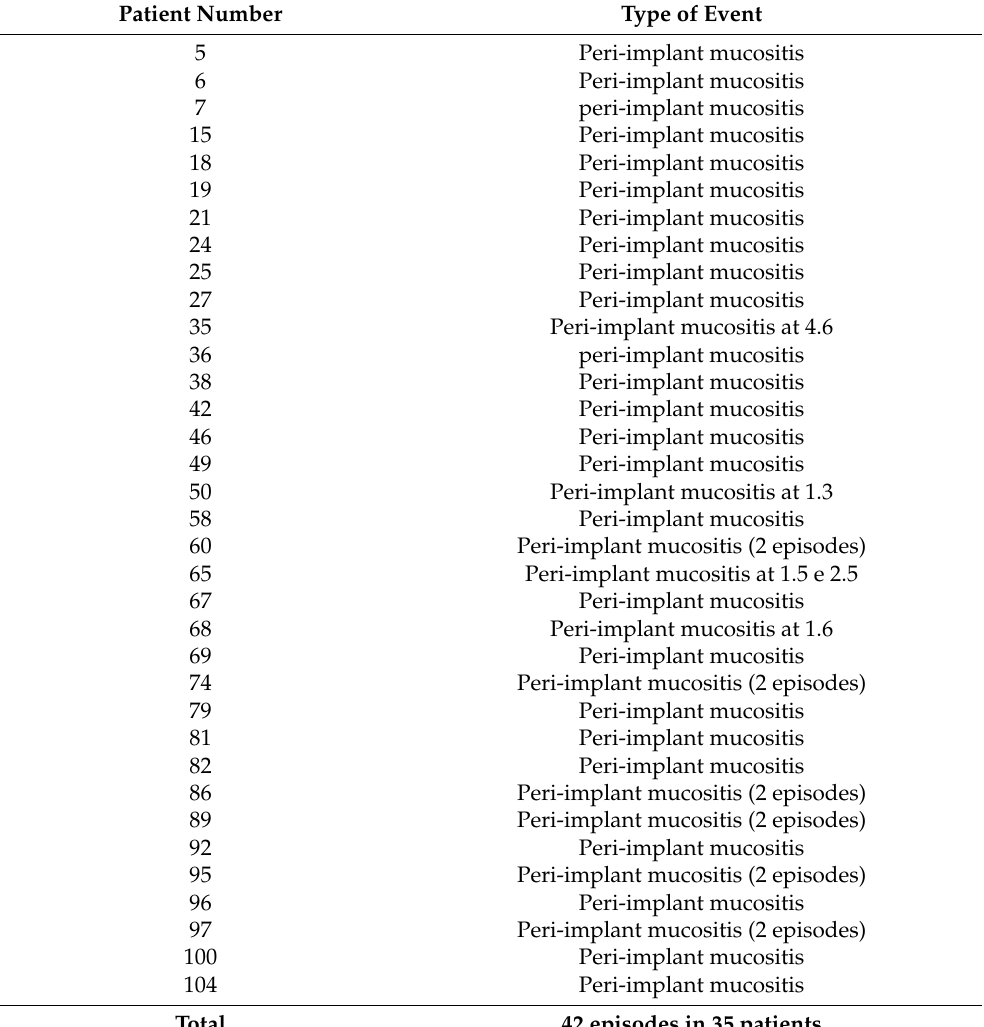
Table 5. Description of peri-implant mucositis episodes.